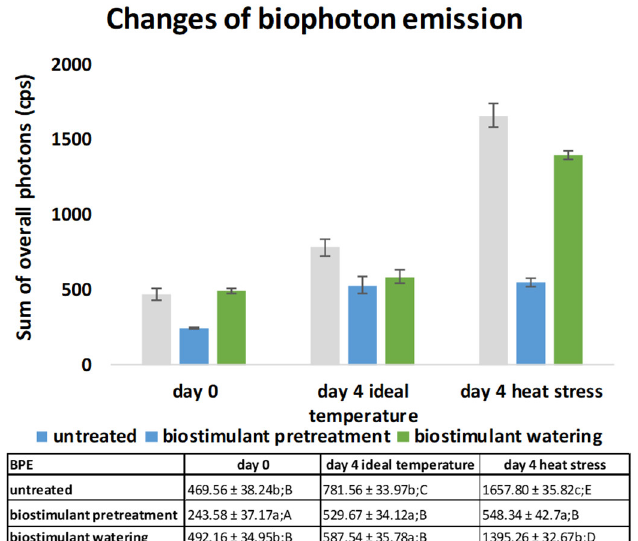
Figure 4. Sum of overall count per second values (cps) of wheat seedlings; mean values ( n = 3) and standard deviations are presented. The same letters represent non-significant difference within each treatment, analyzed with one-way ANOVA ( p < 0.05) with Duncan post hoc test. Upper-case letters refer to time effect, whereas lower-case letters letter refer to the effect of biostimulant treatment within one sampling